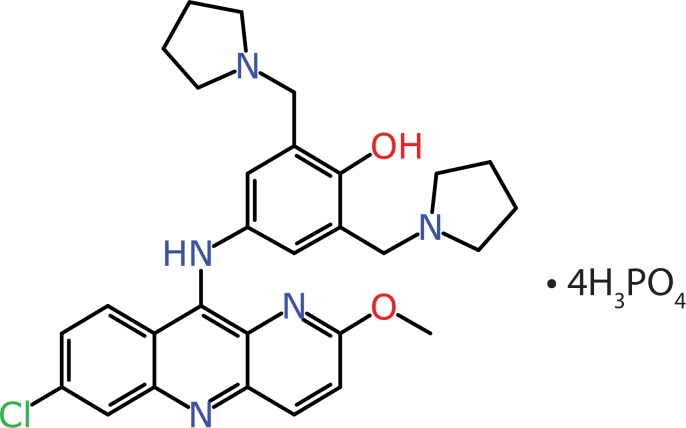
CPI-1058 (Pyronaridine tetraphosphate).